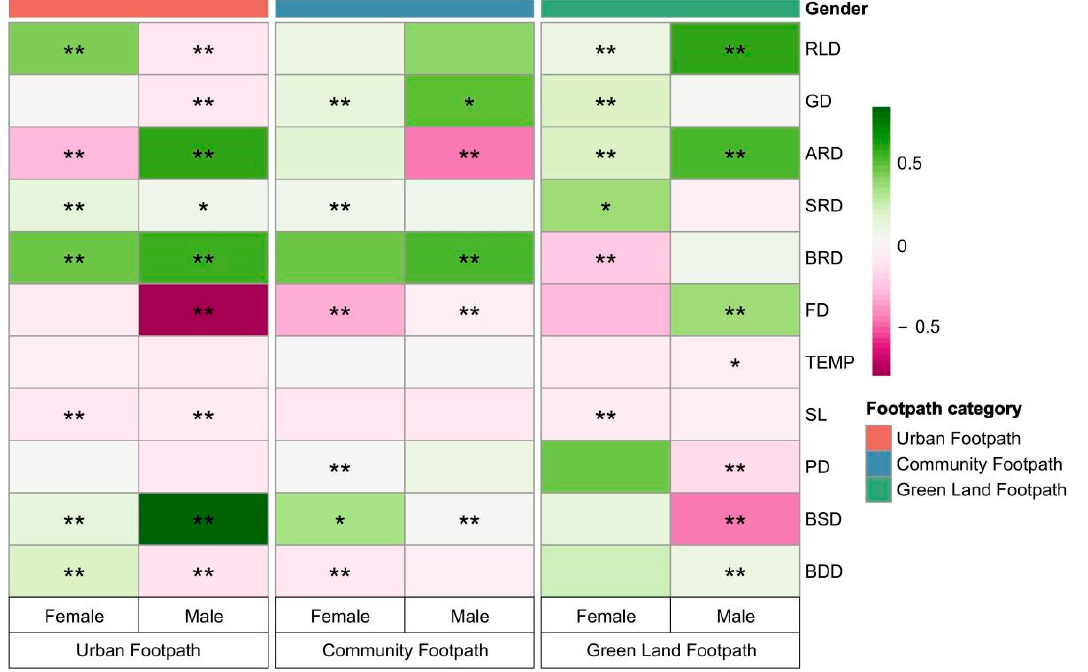
Figure 10. Heat map of the significance comparison of different footpath environments on the JA of different gender groups. Note: green represents a positive value; purple represents a negative value; the depth of the color represents the size of the normalization coefficient; “**” indicates p < 0.01, “*” indicates p < 0.05.